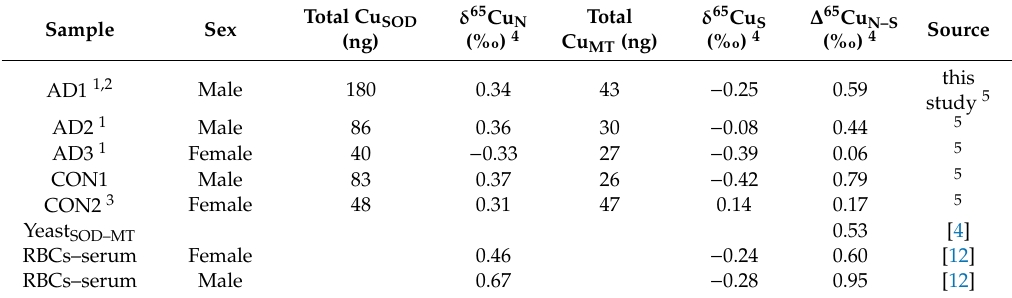
Table 1. The copper isotopic composition of metallothionein and superoxide dismutase isolated from brain homogenates of diseased and non-diseased states and similar values for the same bonding environments from other